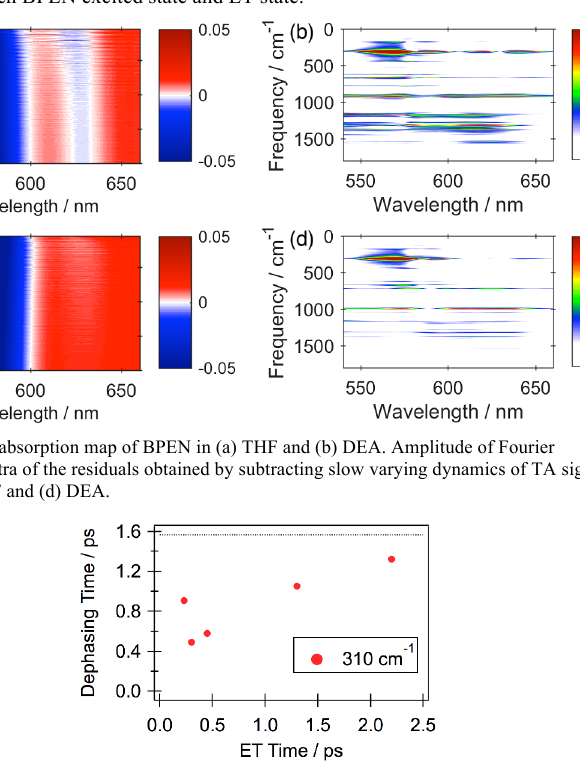
Fig. 2. Dephasing time constant of 310 cm -1 mode at 620 nm in each electron donating solvent plotted against electron transfer time constant. Dashed line represents dephasing time constant in